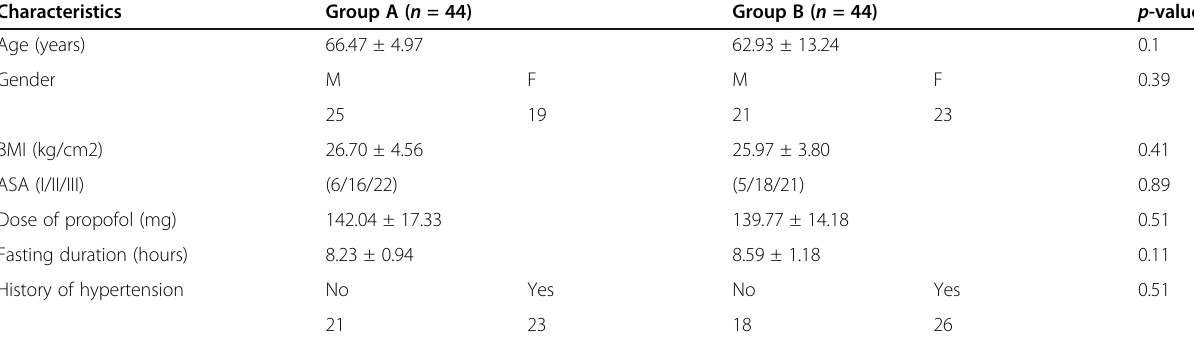
Table 1 Comparison of demographic characteristics between the two study groups Characteristics